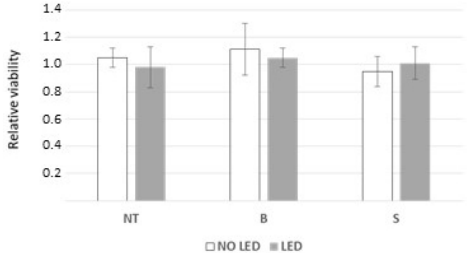
Figure 12. MTS viability of rat normal astrocytes: untreated (NT), after treatment with NPs BBR S (S), or with unloaded NP (B). Unloaded NPs (B) or NP BBR S (S) (both 10 7 particles) were administered to normal rat astrocytes and analyzed by MTS assay after 24 h. Samples (in three independent replicas) were subjected or not to 4 min of light stimulation at 447 nm and 1.2 mW/cm 2 of intensity. Data are reported as mean values of relative viability and standard deviations.